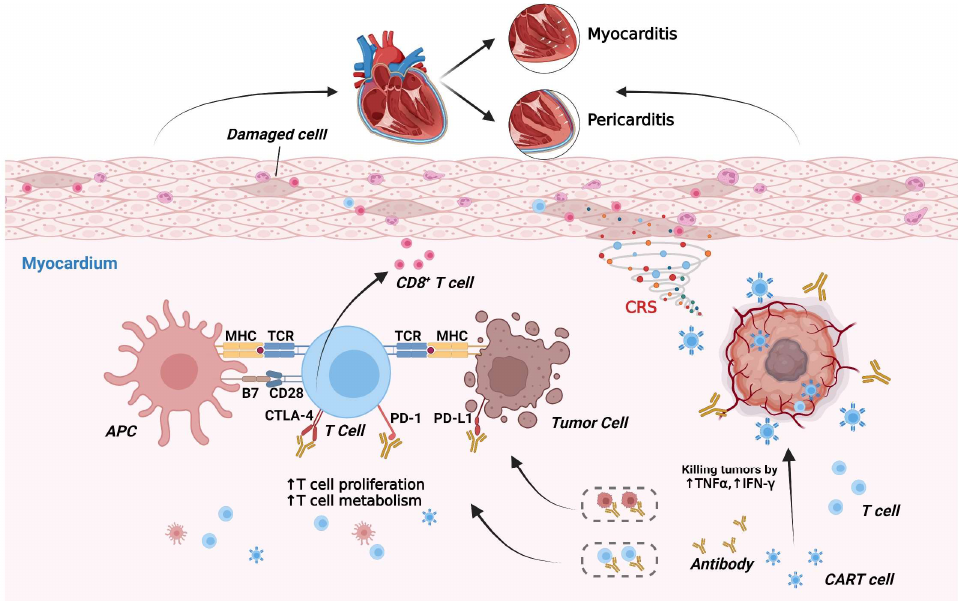
Figure 5. Mechanisms of immunotherapy-induced cardiotoxicity. Inhibition of CELA-4 expression leads to the proliferation and infiltration of CD8 + T cells in the heart. Chimeric antigen receptor T-cell therapy drives CRS to an inflammatory response. APC, antigen-presenting cells; MHC, major histocompatibility complex; TCR, T-cell receptor; CTLA-4, cytotoxic T-lymphocyte-associated antigen-4; PD-1, programmed cell death protein 1; PD-L1, programmed cell death 1 ligand 1; CRS, cytokine release syndrome. Created with BioRender.com.